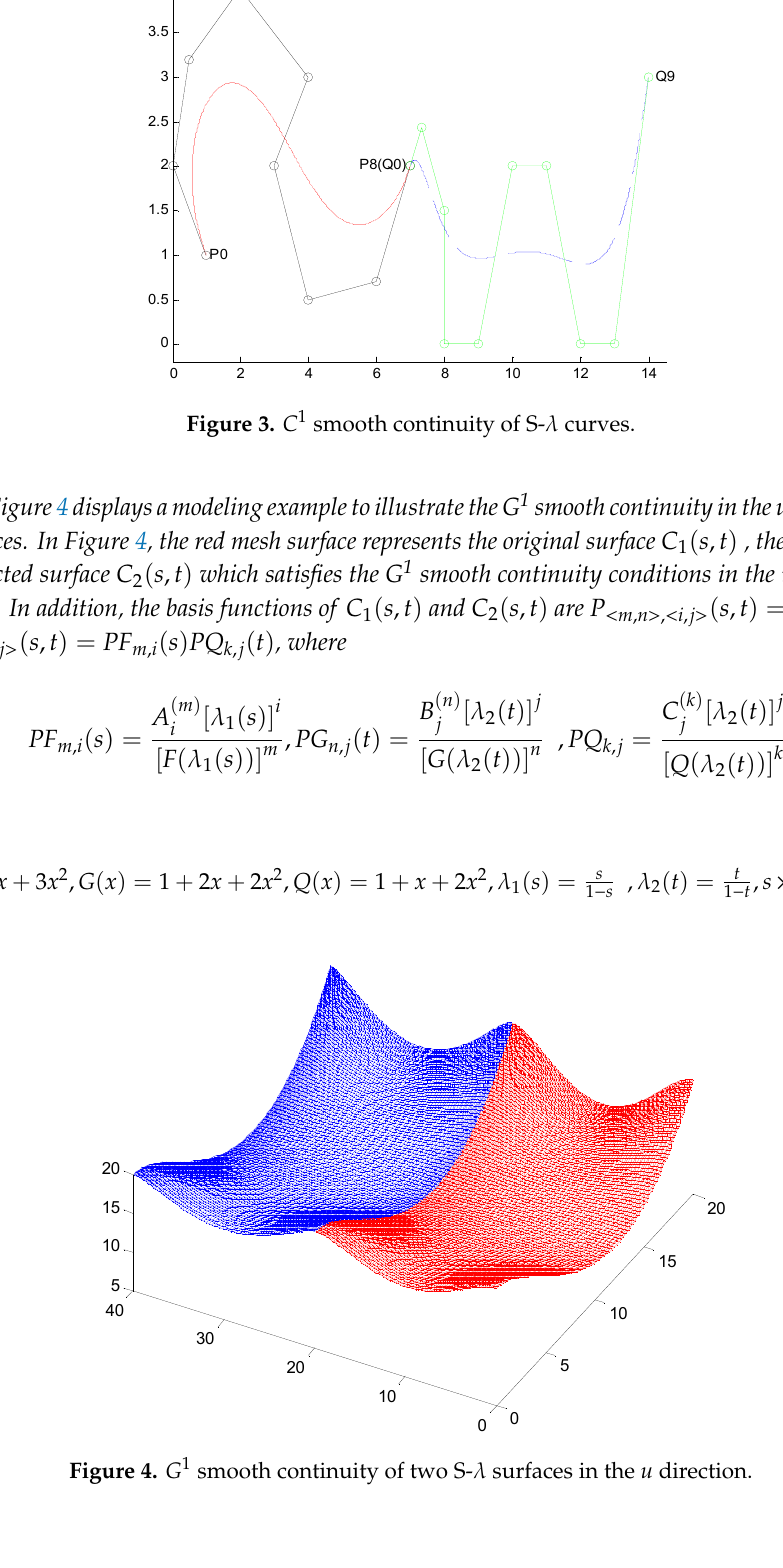
Figure 5. G 1 smooth continuity of two S- λ surfaces in the v direction. Example 5. Figure 5 shows a modeling example to demonstrate the G 1 smooth continuity in the v direction between two S- λ surfaces. In Figure 5, the red mesh surface represents the original surface